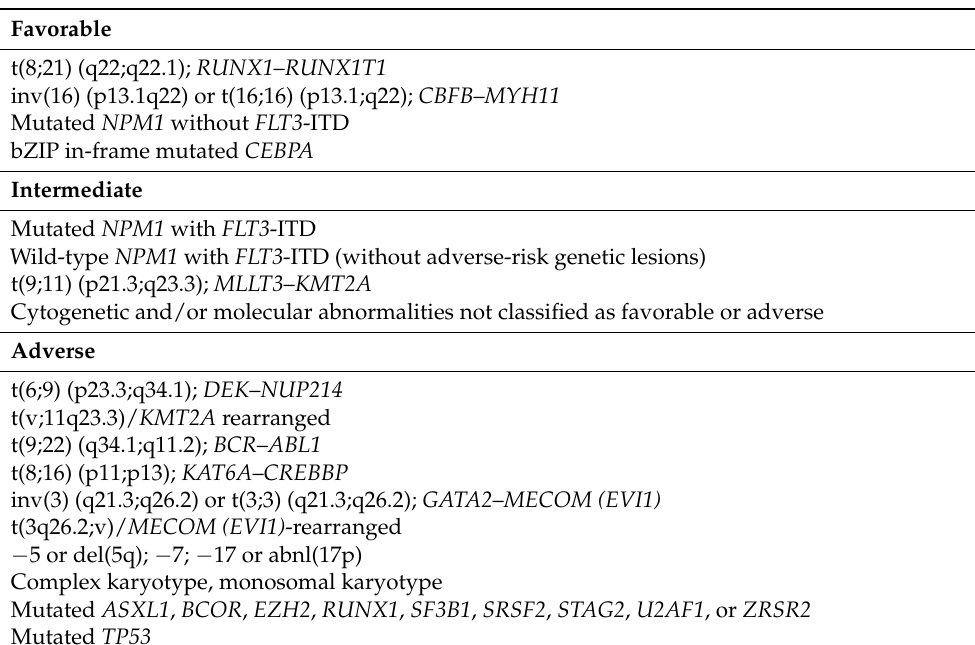
Table 2. Current stratification of de novo and therapy-related acute myeloid leukemia (2022 European LeukemiaNet [ELN] genetic risk classification). For patients with an estimated risk of relapse >35–40% (i.e., patients with adverse and the majority of patents with intermediate-risk profile), allogeneic hematopoietic stem-cell transplantation is